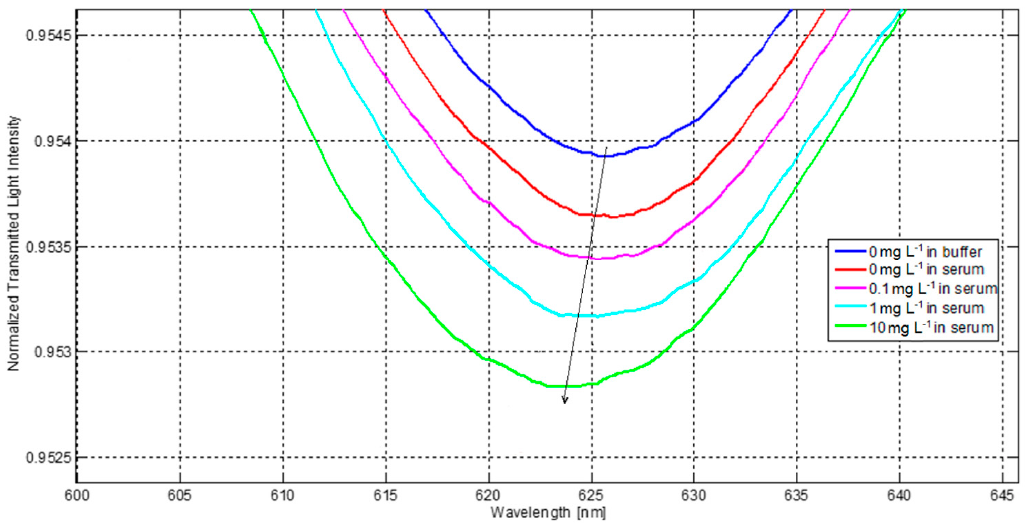
Figure 7. Normalized SPR spectra acquired by the POF-SPR biosensor for different analyte concentrations in serum.